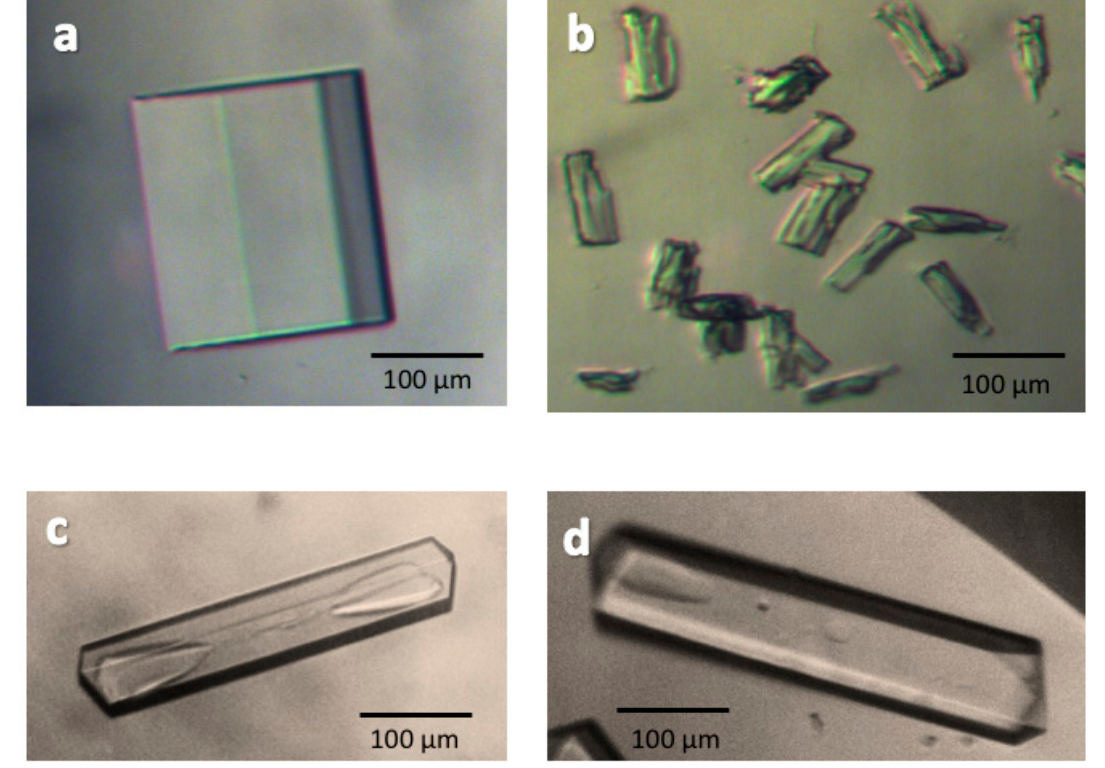
Figure 5. ( a ) Optimal temperature and crystallization conditions for apo-transferrin at 18 ◦ C, ( b ) crystals grown at 19 ◦ C were slightly dissolved. Crystal conservation over time: ( c ) Crystals grown during three days after crystallization; and ( d ) crystal observed after transportation (trip) to the synchrotron facility 2.5 months later. The crystals were preserved inside these devices and worked as thermal